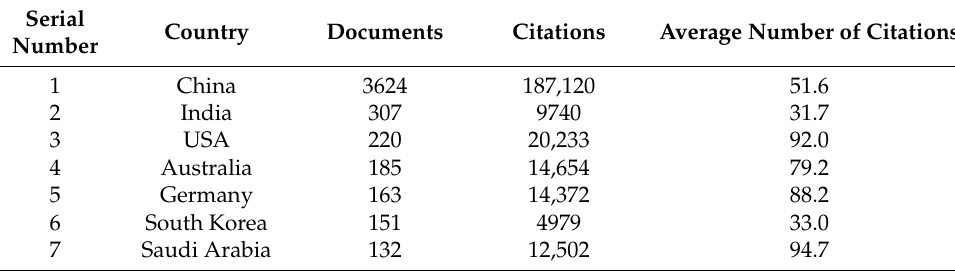
Table 3. National publication volume and citation information.